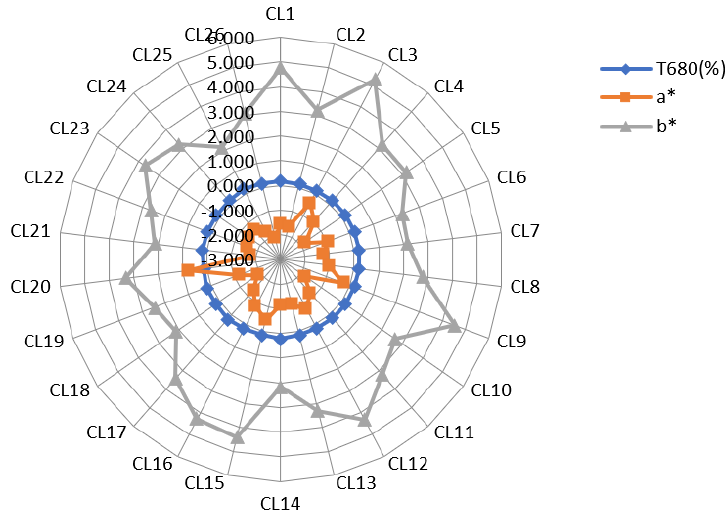
Figure 2. The T680 (%), a* value, b* value of the juices of 26 celery cultivars.